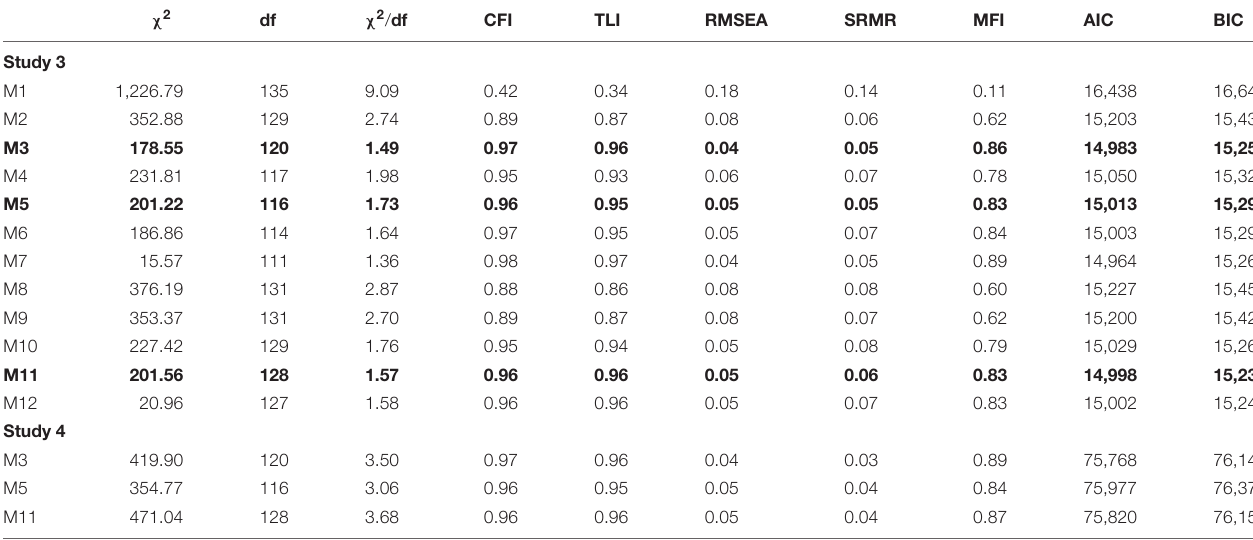
TABLE 6 | Results of confirmatory factor analysis (CFA) of the Implicit Theories Scale from Study 3 and Study